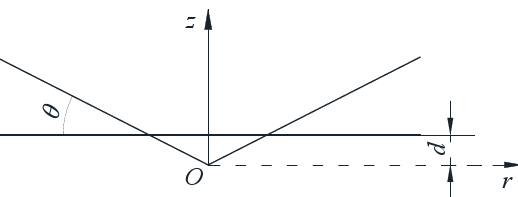
Figure 1. Contact form between rigid conical indenter and elastic half-space body.